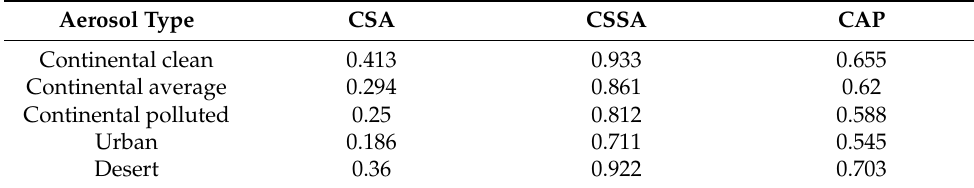
Table 2. Summary of CSA, CSSA, CAP values for the five different aerosol types listed in Table